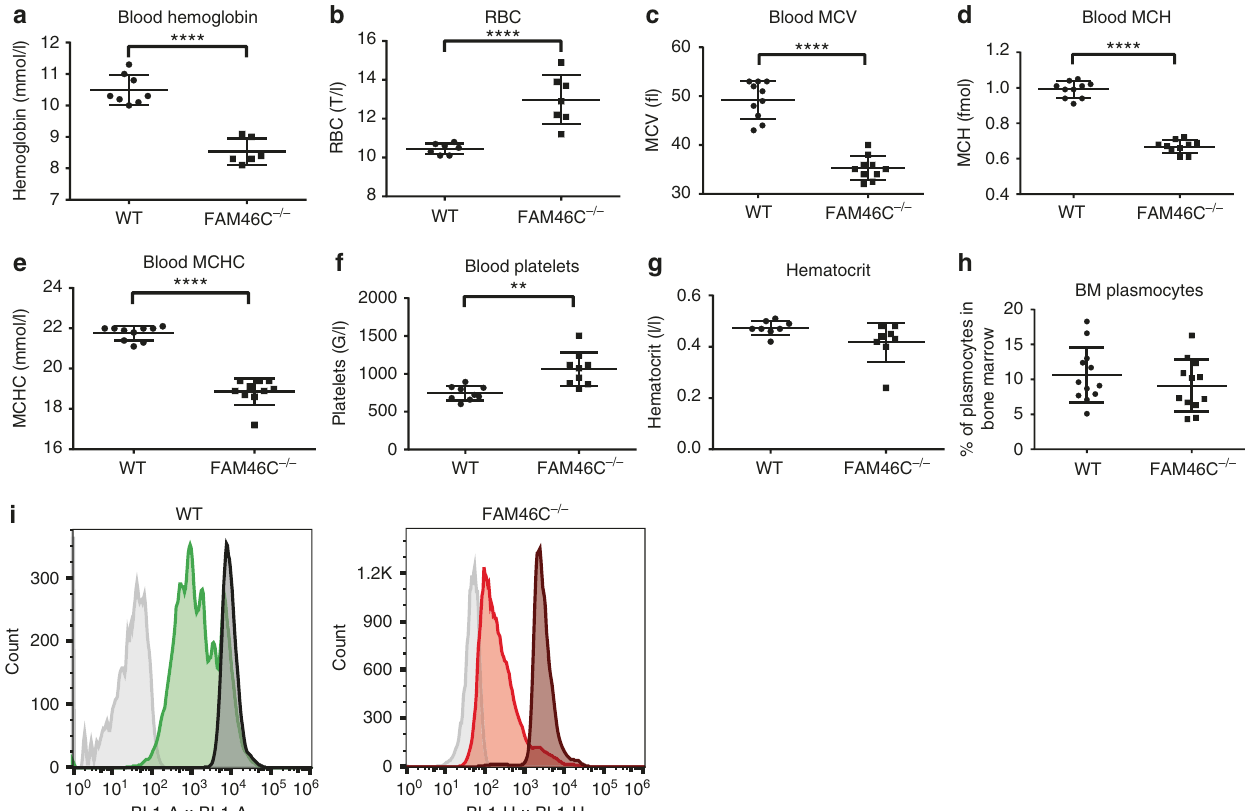
Fig. 6 FAM46C KO 12-week-old mice display reduced blood hemoglobin levels and activated primary B lymphocytes proliferate faster. a – h Hematologic parameters of FAM46C KO and control animals: a Blood hemoglobin concentration (WT, n = 8; FAM46C KO, n = 6); b red blood cells count (RBC) (WT, n = 7; FAM46C KO, n = 7); c mean corpuscular volume (MCV) (WT, n = 10; FAM46C KO, n = 10); d mean corpuscular hemoglobin (MCH) (WT, n = 10; FAM46C KO, n = 10); e mean corpuscular hemoglobin concentration (MCHC) (WT, n = 10; FAM46C KO, n = 10); f blood platelets (WT, n = 9; FAM46C KO, n = 9); g Hematocrit (WT, n = 8; FAM46C KO, n = 8); h bone marrow (BM) plasmocytes (WT, n = 12; FAM46C KO, n = 12). P -values were calculated using two-way ANOVA tests (** P < 0.01, **** P < 0.0001). i Analysis of the proliferation rate of activated primary B cells. B lymphocytes isolated from FAM46C KO mice and matching WT controls were stained with CFSE and in vitro activated using IL4 and LPS. Cell divisions were monitored by levels of CFSE dilution. One representative experiment of 2 is presented. For each experiment splenic B lymphocytes from three individuals have been pulled, for both WT and mutant